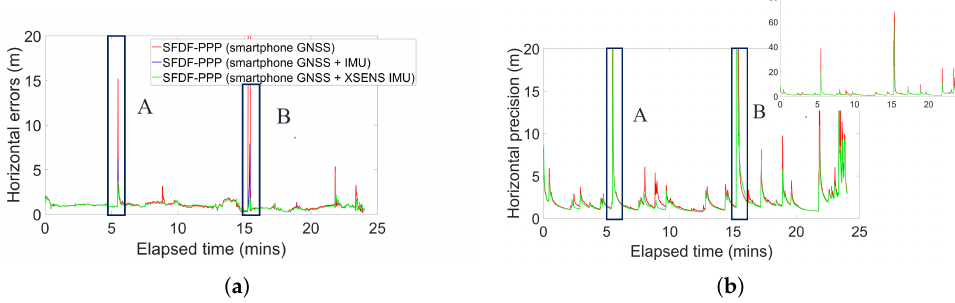
Figure 10. Horizontal error with respect to the reference trajectory and filter estimated precision comparison for single- and dual-frequency PPP processing using smartphone GNSS measurements, GNSS + IMU measurements, and GNSS and Xsens IMU measurements. ( a ) Horizontal position error. ( b ) Horizontal precision estimate.